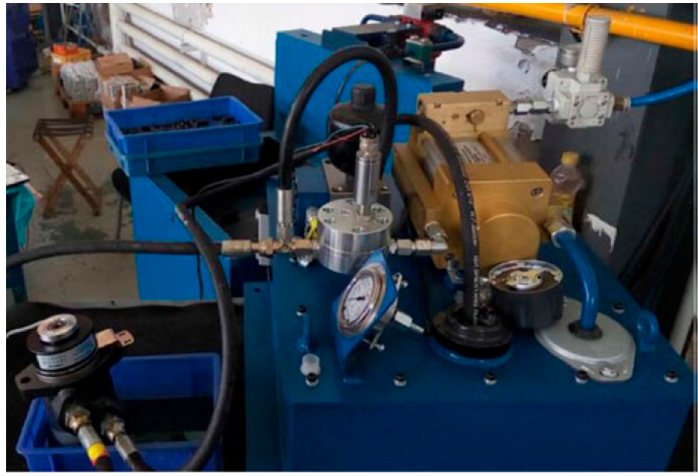
Figure 4. Dedicated test bench for the HP transformer.